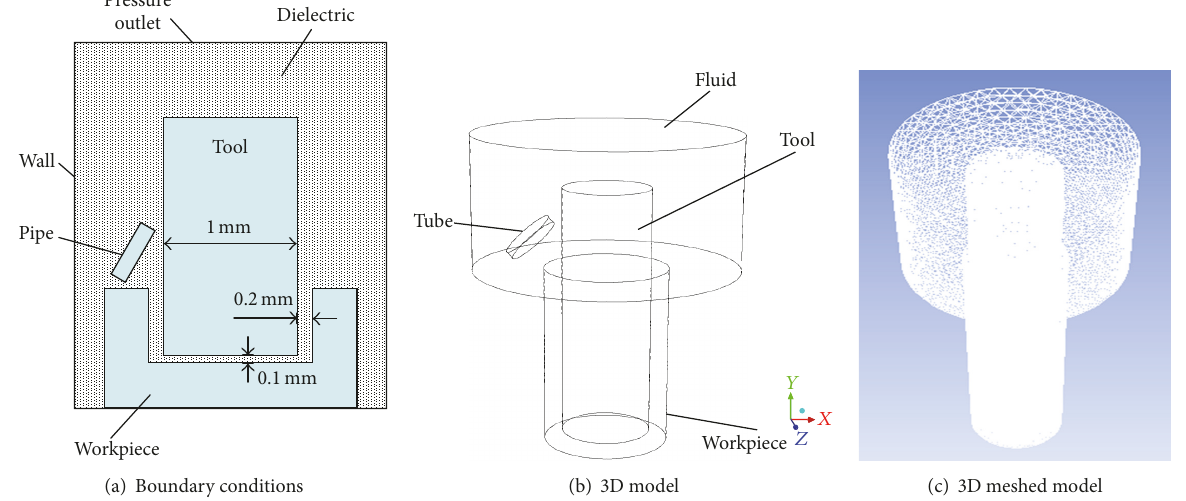
Figure 3: The schematics of 2D boundary conditions and 3D meshed